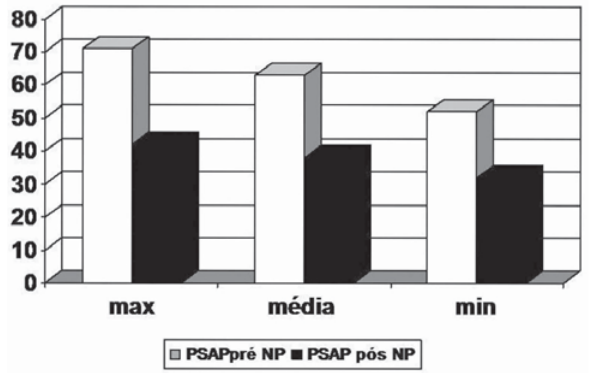
Fig. 2 - Pressões arteriais pulmonares no intra-operatório pré e pós uso de nitroprussiato de